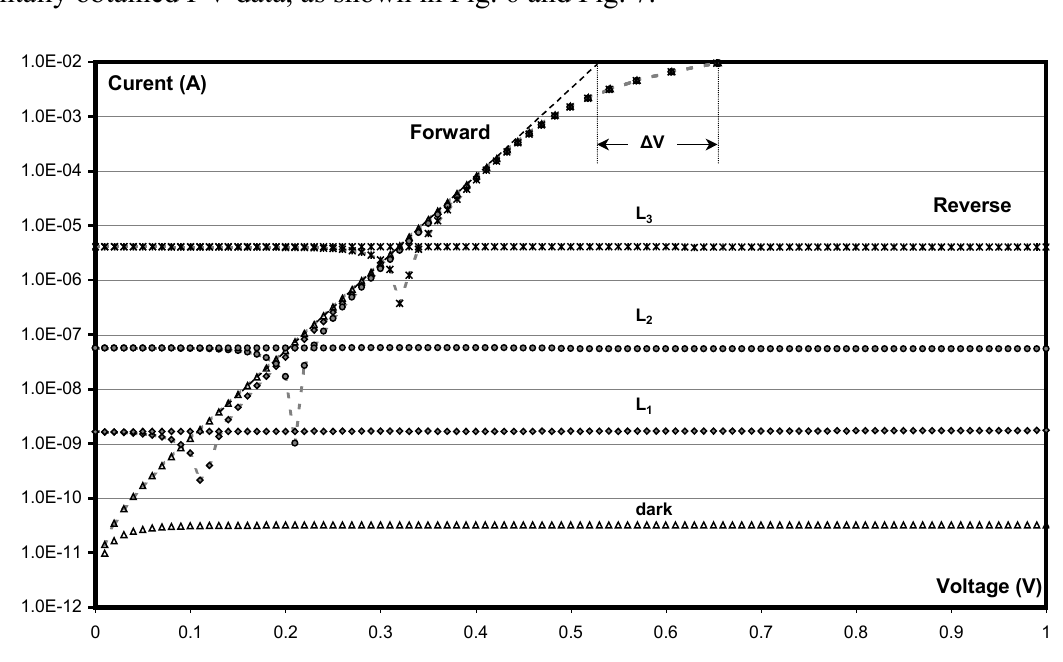
(L ) = 4.02 x 10 -6 A. Notice remarkable similarities to the opt 3